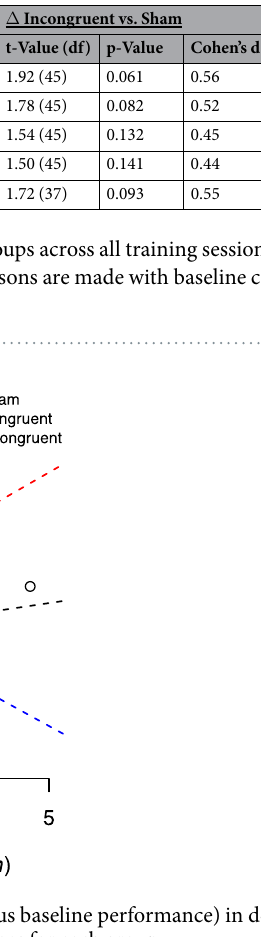
Figure 2. Training gains (performance at T4 minus baseline performance) in dependency of baseline performance. Dashed lines are linear regression lines for each